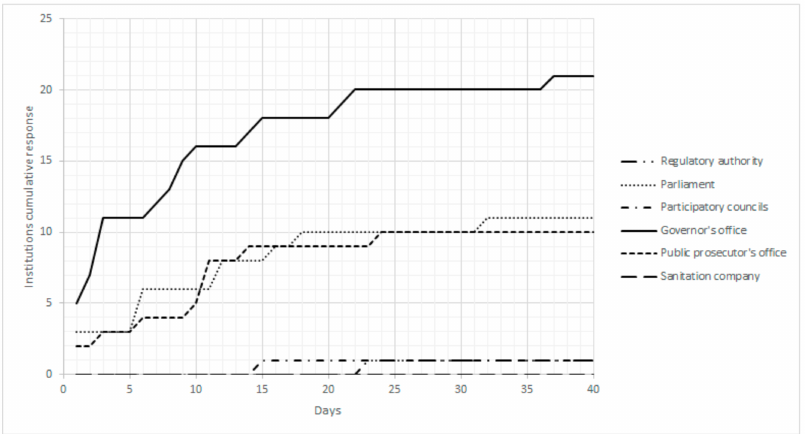
Figure 2. Institutional measured responses to the coronavirus pandemic in the first 40